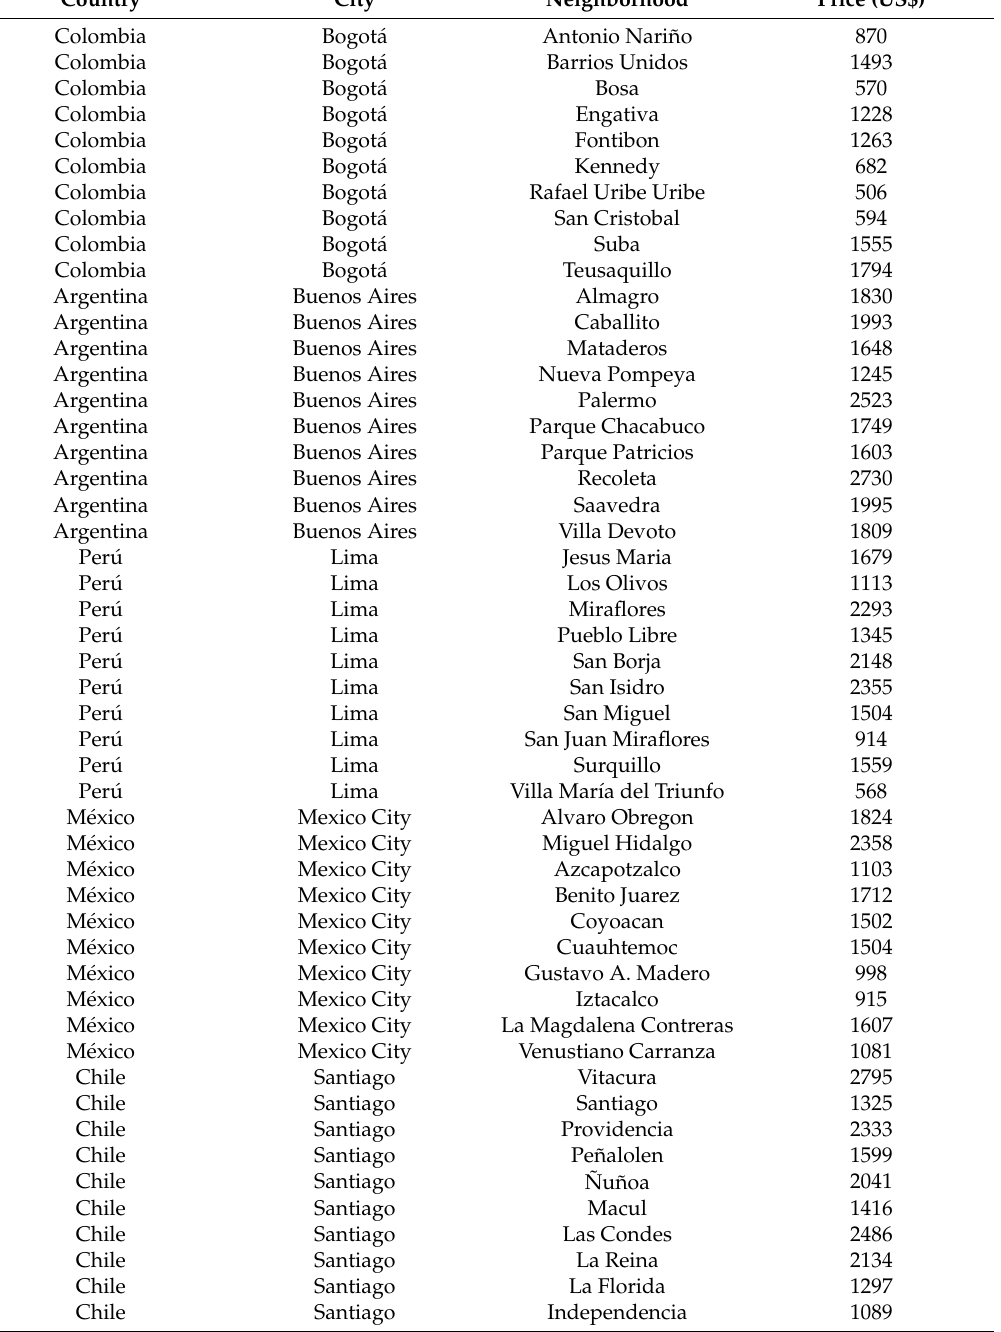
Table A1. Real Estate Data: US$/m 2 at district level